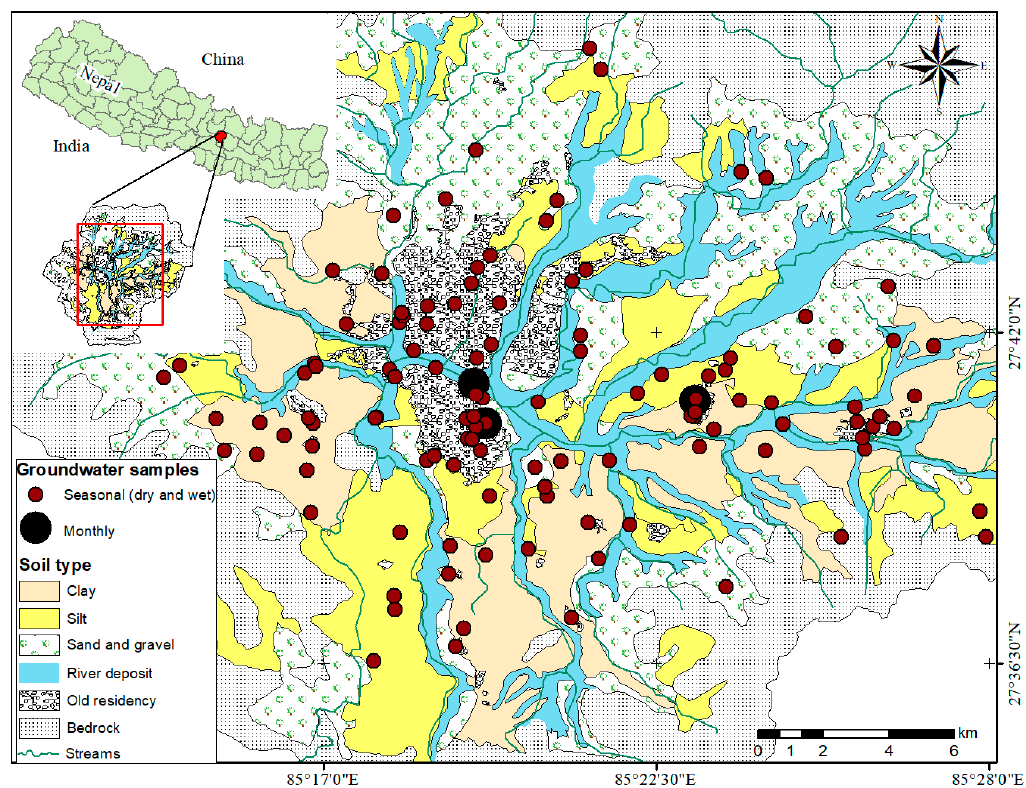
Figure 1. Spatial distribution of groundwater samples collected in both the dry and wet seasons. The background represents the shallow subsurface soil (after Bundesanstalt für Geowissenschaften und Rohstoffe (BGR) [31],